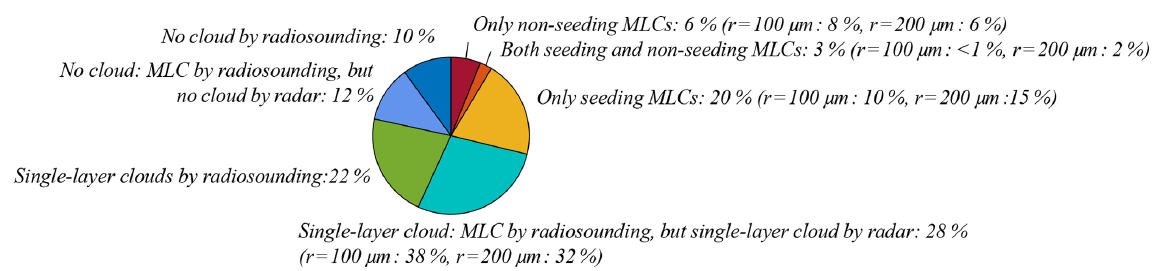
Figure 9. Cloud occurrence derived from using both radiosonde and radar for detection. For the categories the same colours as in Fig. 1 are used. A total of 100% equals 278 days (analysed days within the 1-year dataset). Seeding and non-seeding is calculated using a hexagonal plate of initial size r = 400µm. Percentages in brackets refer to the calculations using different initial ice crystal sizes r = 100 and 200µm. The values are rounded to zero decimal places.